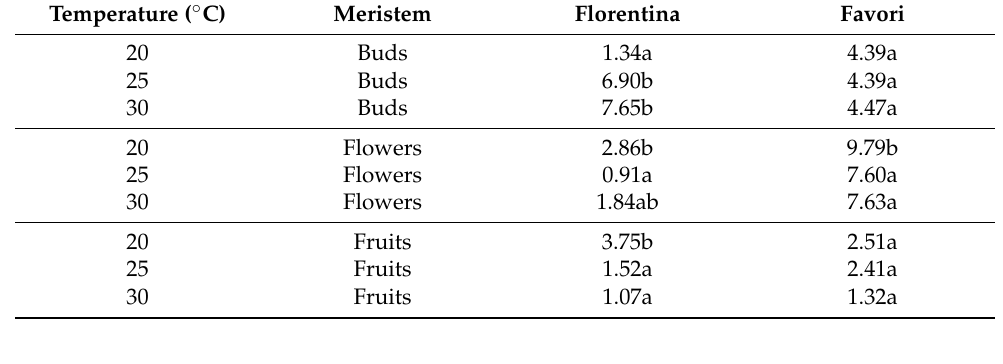
Table 4. Pairwise comparison of the least squared means of the meristematic development between the temperature treatments in SD for ‘Florentina’ and ‘Favori’. The least square means followed by the same lowercase letter did not differ statistically by the Tukey test at 5% of error probability ( p < 0.05).